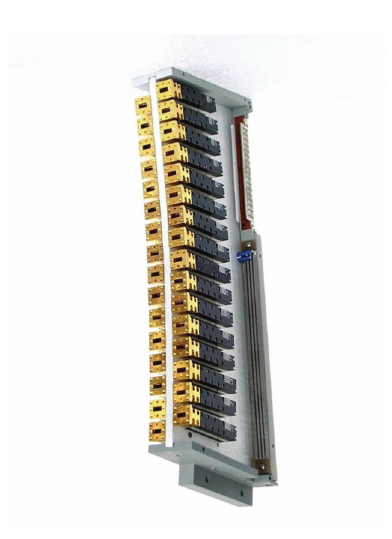
Figure 4: Array with 32